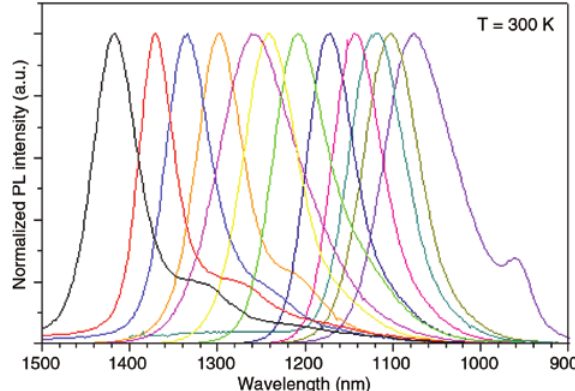
Figure 3: The wavelength of emission from the excitonic ground state of a QD can be varied by varying its size and composition and that of the matrix.